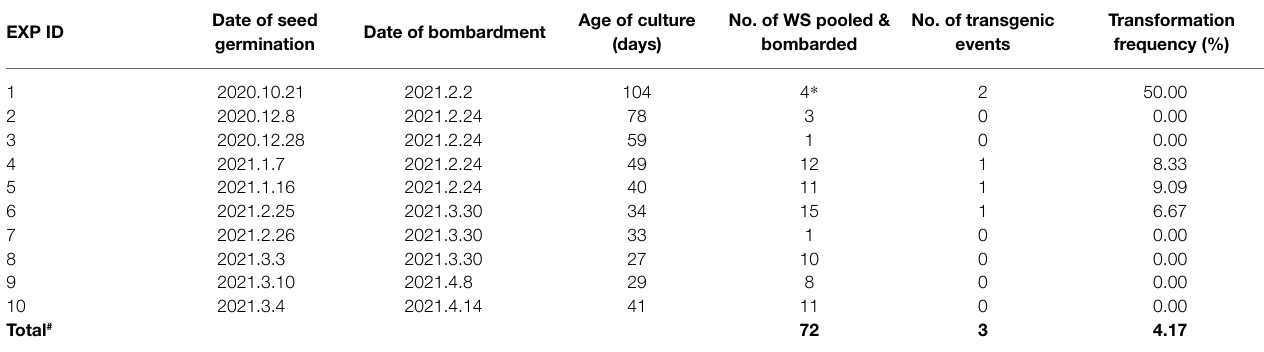
TABLE 2 | Summary of 10 biolistic transformation experiments using RS callus culture and pRK2155. EXP